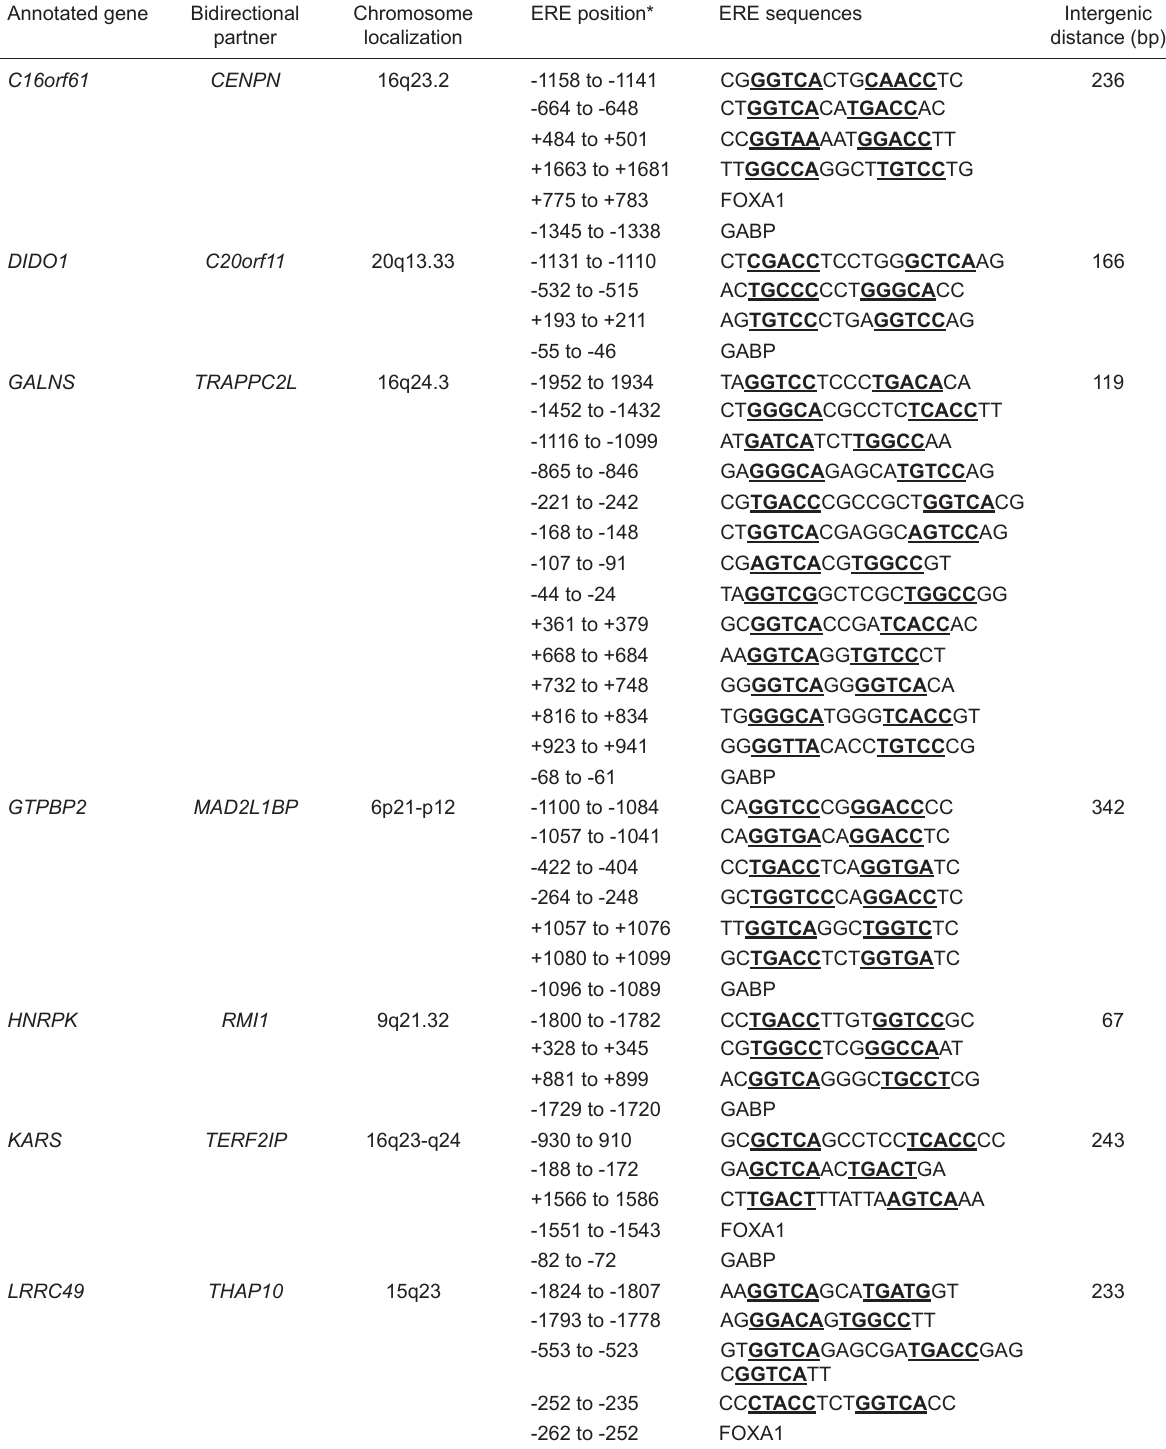
Table 1. List of the bidirectional gene pairs identified. Annotated